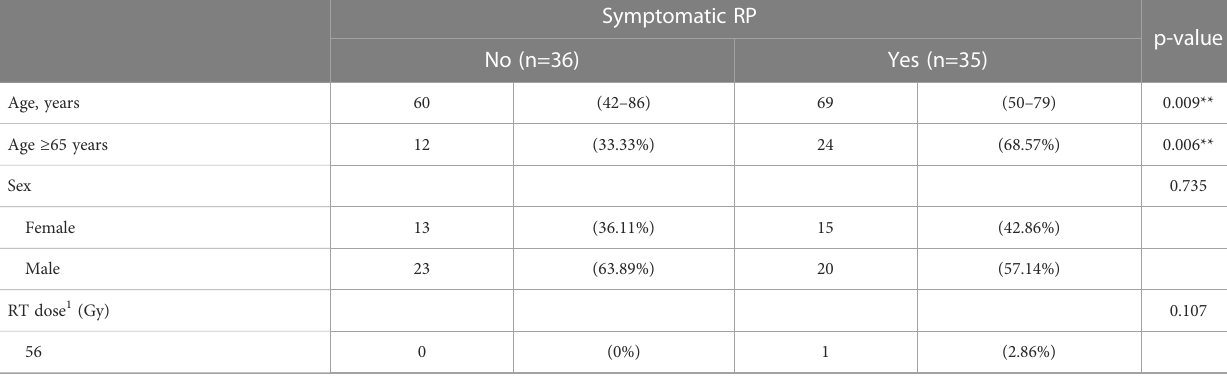
TABLE 3 Patient characteristics in non-symptomatic and symptomatic